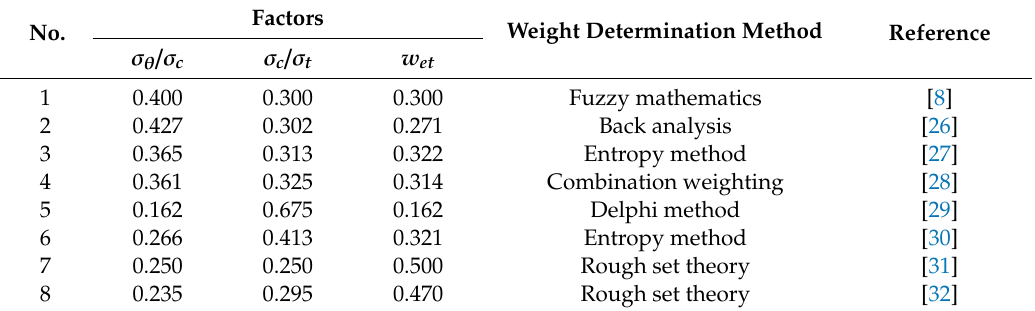
Table 1. The weights of the rockburst prediction factor obtained by di ff erent